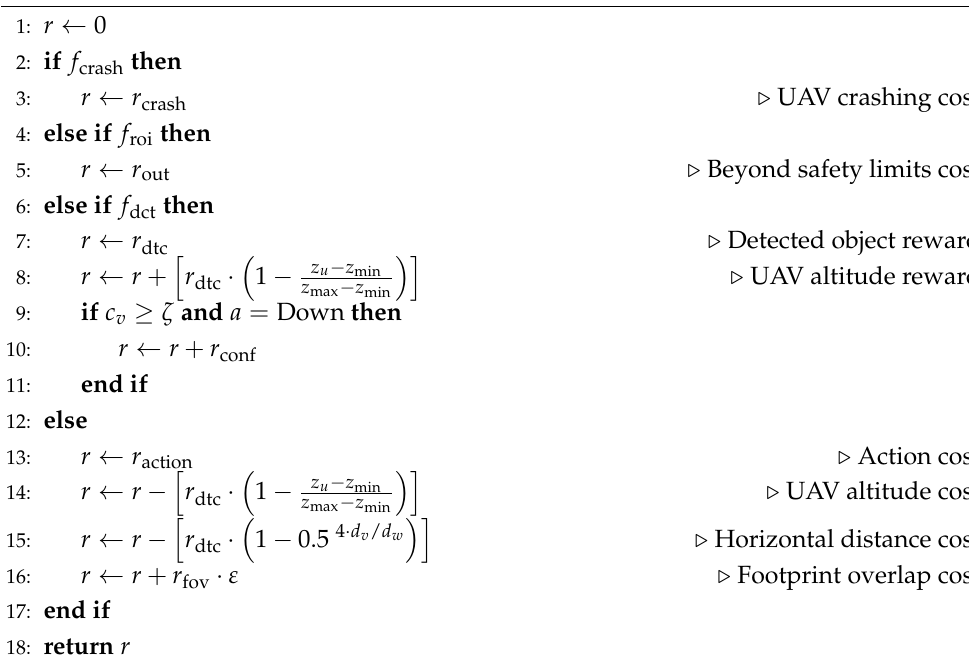
Algorithm 1 Reward function R for exploration and object detection.